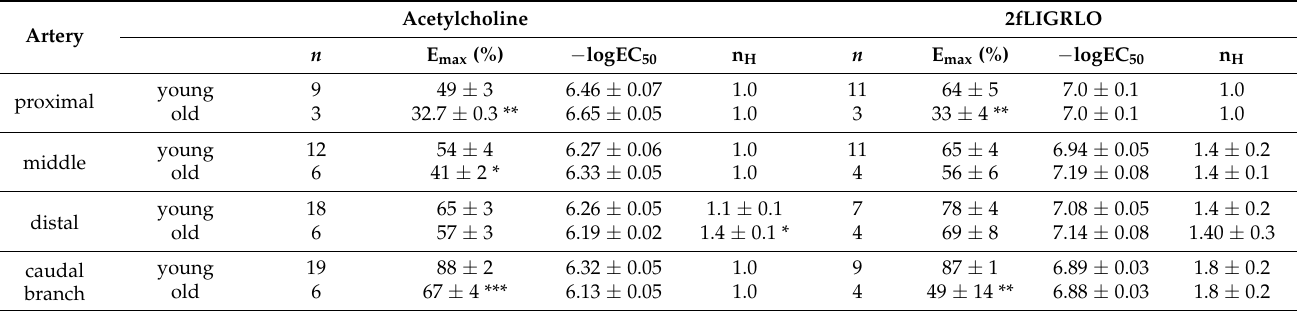
Table 4. Concentration–response curve parameters for acetylcholine, 2fLIGRLO-induced relaxations of saphenous artery segments, and caudal branches from young and old Sprague Dawley